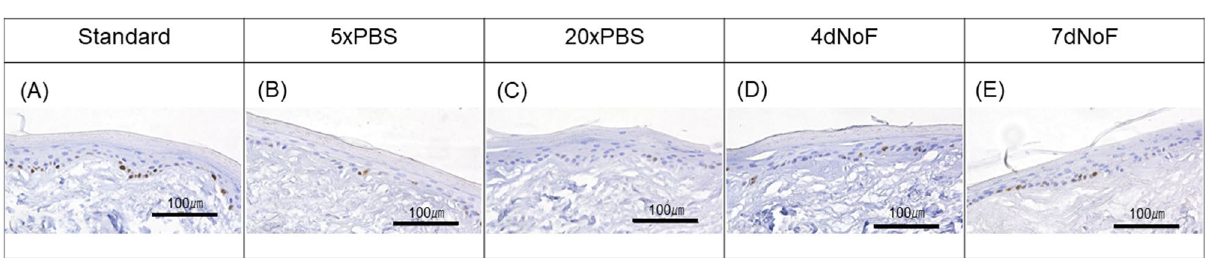
Figure 7. Ki-67 immunohistochemical analysis of the EVPOME received metabolic challenges compared with the standard protocol. Representative images of Ki-67 immunohistochemistry of the EVPOMEs. Ki-67-positive cells are mainly present in the basal layer. The number of Ki-67 positive cells was remarkably fewer when cells received metabolic challenges before development of the EVPOMEs. ( A ) Standard protocol, ( B ) metabolic challenge of 5×PBS, ( C ) metabolic challenge of 20×PBS, ( D ) metabolic challenge of 4dNoF, ( E ) metabolic challenge of 7dNoF. Original magnification × 40. Scale bar = 100